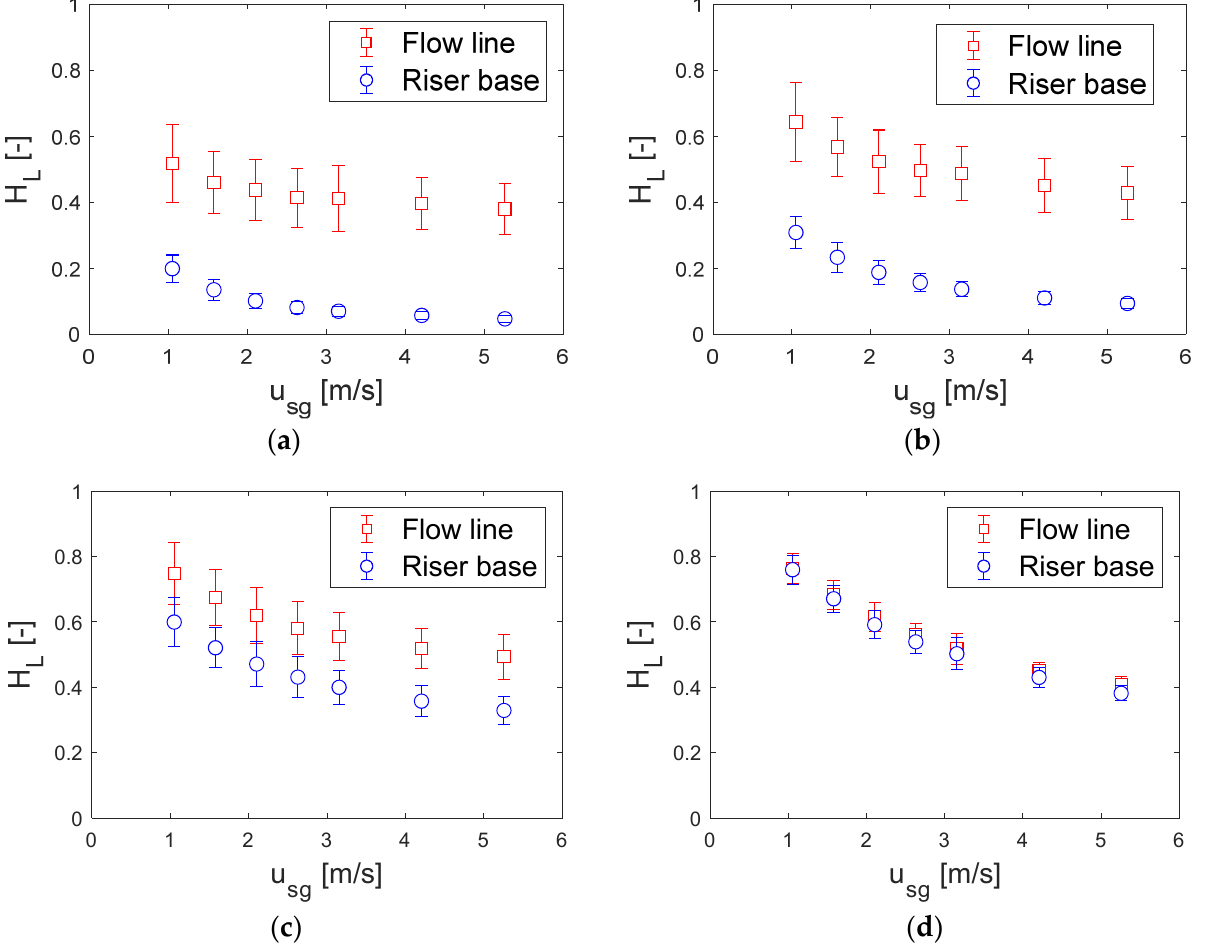
Figure 6. Trends of mean gamma densitometer liquid holdup with superficial gas velocity for ( a ) 𝑢 = 0.25 m/s ( b ) 𝑢 = 0.5 m/s ( c ) 𝑢 = 1 m/s ( d ) 𝑢 = 2 m/s.